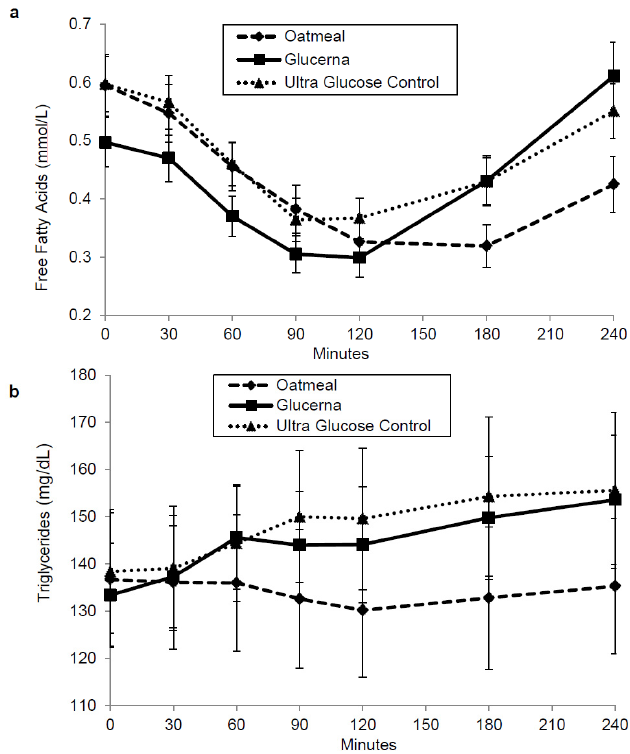
Figure 4. Postprandial free fatty acids ( a ) and triglycerides ( b ) in response to the breakfast meals. Values are mean ± SEM.